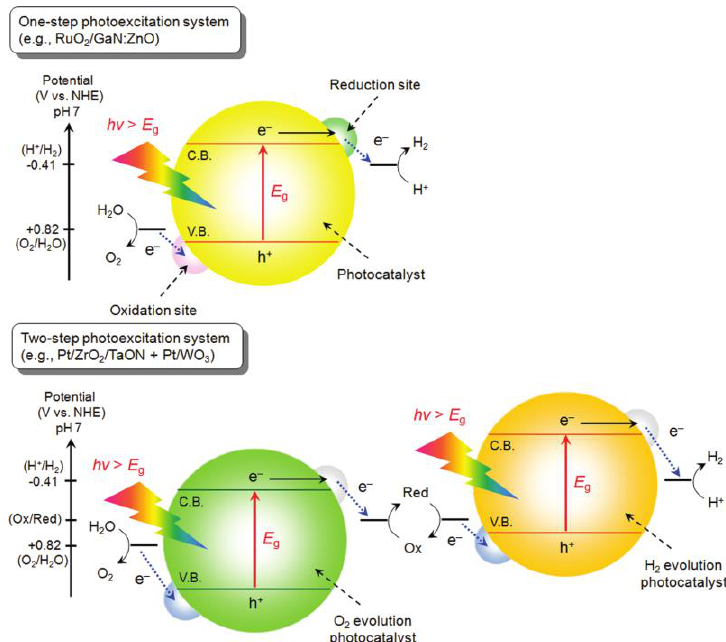
Figure 1. Schematic diagram of one- and two-step photocatalytic water splitting. Reproduced from [51] with permission from American Chemical Society, 2010.